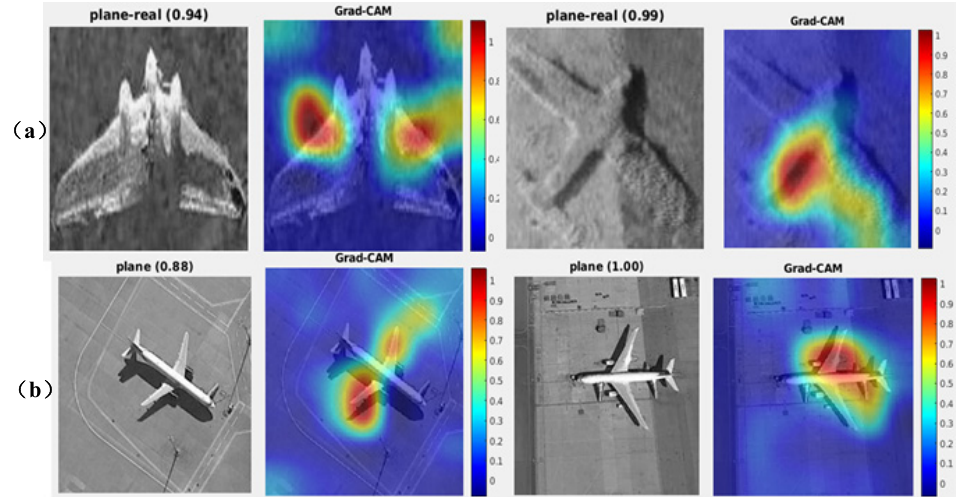
Figure 12. Class activation heatmaps of airplane classification in SSS images and optical images: ( a ) Heatmaps of SSS images; ( b ) Heatmaps of optical images.